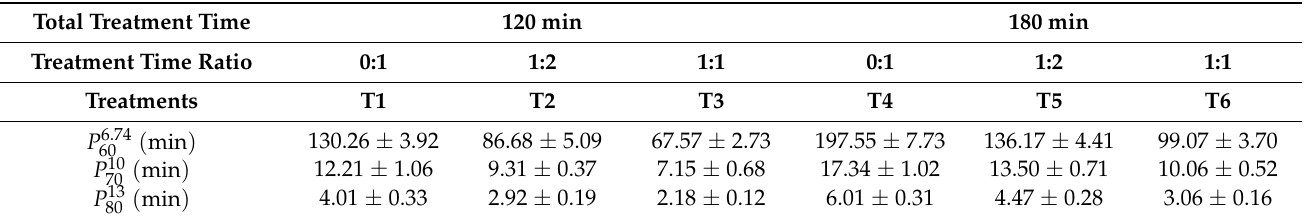
Table 2. Means ± standard deviations of pasteurization values ( P 6.74 ( pectoralis major ) cooked with different combinations of temperatures and time